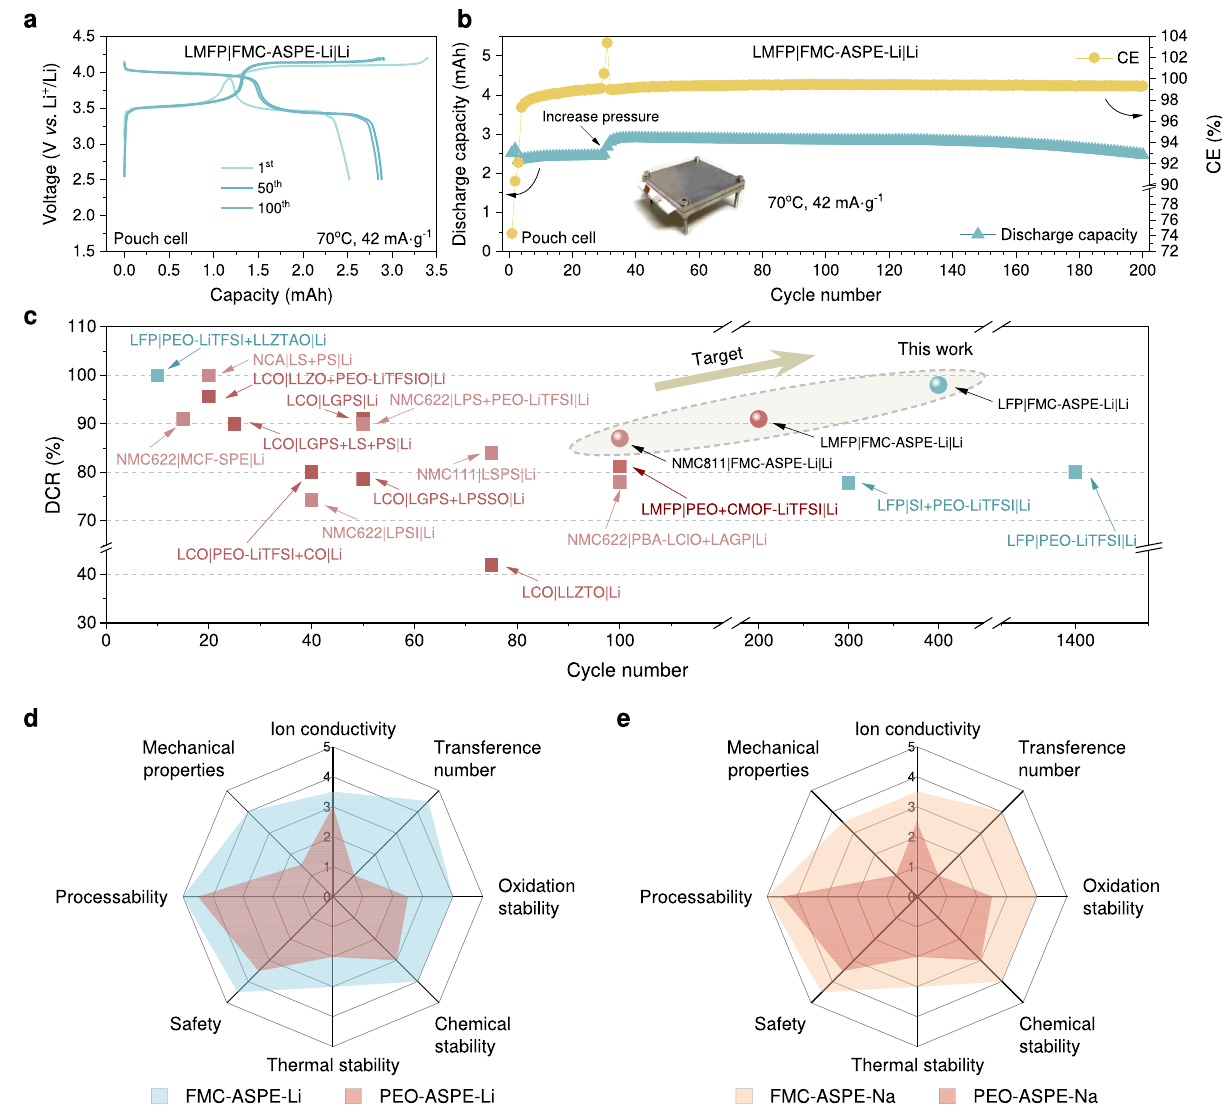
Fig. 8 Cycling performance of lithium metal pouch cells with the LMFP cathode and FMC-ASPE-Li. a , b Charge/discharge voltage pro fi les a for different cycles and corresponding b Discharge capacity with the cycle number of the LMFP|FMC-ASPE-Li|Li pouch cell, with the photo of the test fi xture inserted. The mass of the positive electrode active material was used for calculating the speci fi c current. The initial pressure applied was 0.63 × 10 − 3 MPa, and the increased pressure after the screws was 0.28 MPa after 30 cycles. c Comparison of cycling performance of different all-solid-state lithium batteries (LiCoO 2 (LCO), Li(Ni 0.6 Co 0.2 Mn 0.2 )O 2 (NCM622), Li(Ni 0.3 Co 0.3 Mn 0.3 )O 2 (NCM111), Li(Ni 0.8 Co 0.15 Al 0.05 )O 2 (NCA), poly(ethylene oxide) (PEO), LiFePO 4 (LFP), LiMn